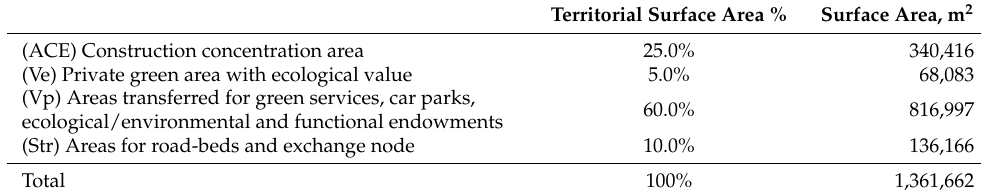
Table 4. Ecological-functional breakdown